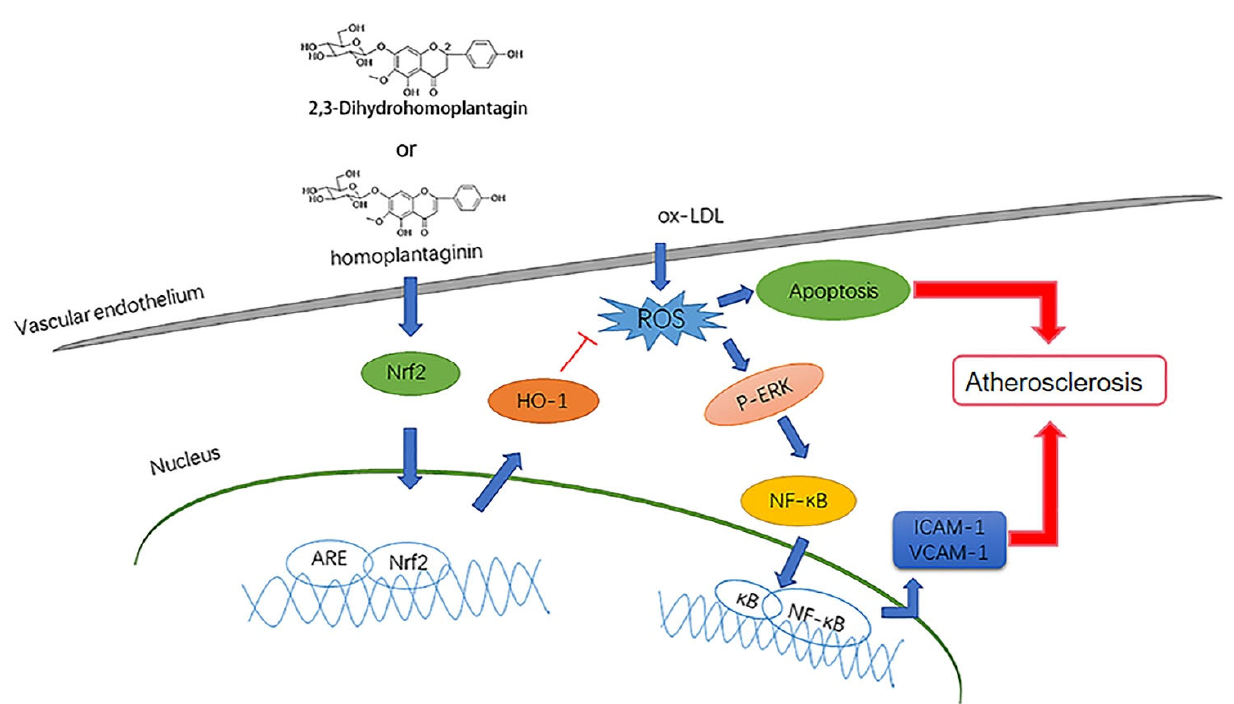
Figure 10. Scheme summarizing the mechanism for inhibition effects of dihydrohomoplantagin (S1) and homoplantaginin (S3) on oxLDL-induced VEC injury and atherosclerosis. OxLDL induces ROS production and NF-kB nuclear translocation by inducing ERK phosphorylation, which contributes to VEC apoptosis, adhesion molecule expression and thus the atherosclerosis development. Dihy- drohomoplantagin and homoplantaginin activate Nrf2 nuclear translocation and the target gene HO-1 expression, which suppress cellular ROS accumulation, the phosphorylation of ERK and NF- κ B activation induced by oxLDL.